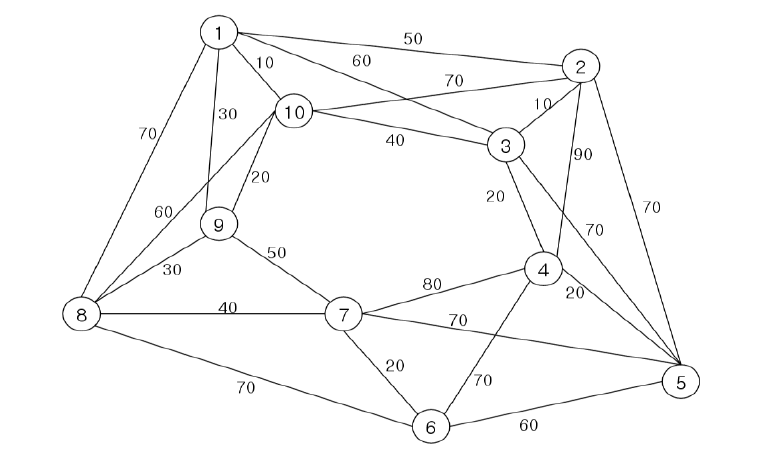
Figure 5. Sample TSP